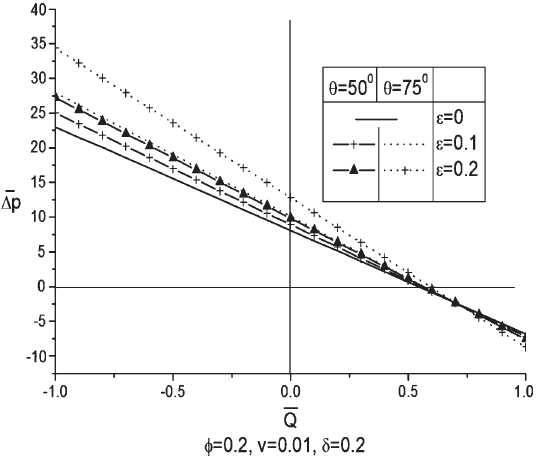
Fig. 4. Variation of pressure rise over the length versus ¯ Q with different values of eccentric parameter (cid:2) with different θ .